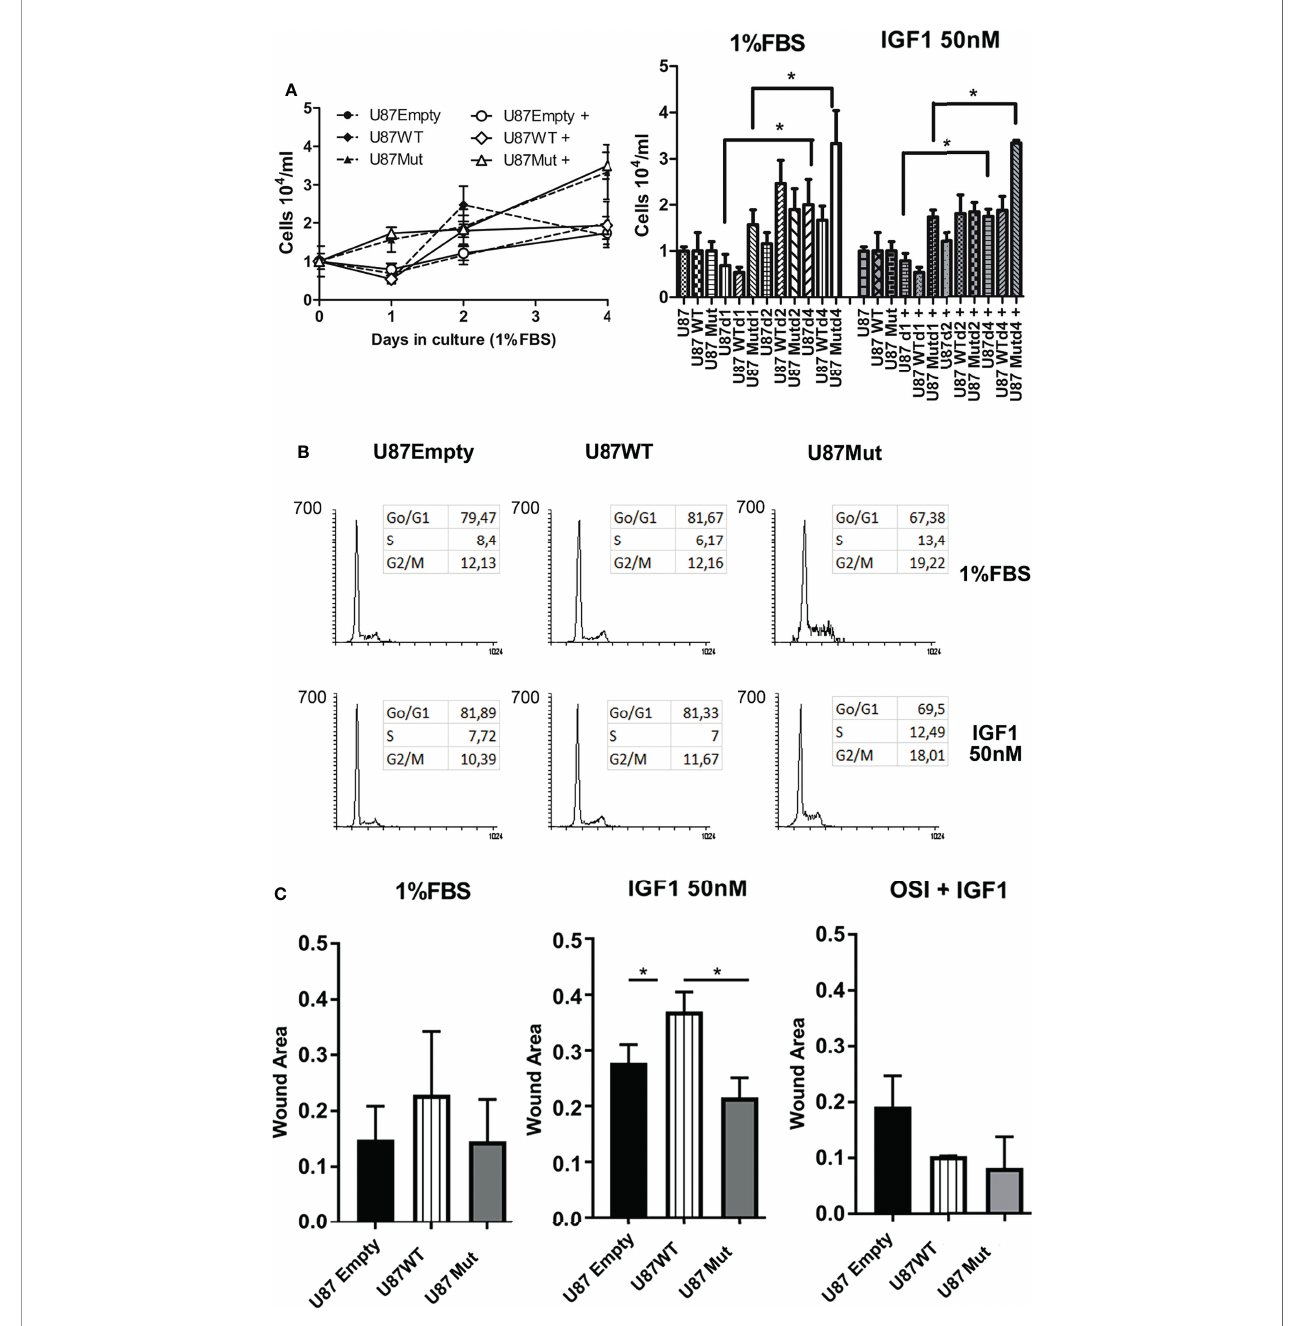
FIGURE 2 | Effects of IGF1R localization over the proliferation and migration of glioma cells. (A) Left: U87Empty (solid circles), U87WT (solid rhomboids), and U87Mut (solid triangles) cells were grown for 4 days with low serum concentration (1% FBS) or in the presence of 50 nM IGF1 [U87Empty + (open circles), U87WT+ (open rhomboids), and U87Mut+ (open triangles)]. The results of a representative experiment from a total of three performed in triplicates are shown; Right: total number of cells, according to cell line, days in culture, and treatment. Values are expressed as mean ± SD (* p < 0.05, ANOVA, Tukey ’ s post-test). (B) U87Empty, U87WT, and U87Mut cells were cultured 24 h in low-serum conditions (1% FBS) with or without 50 nM IGF1 stimulus, fi xed, stained with PI, and analyzed by fl ow cytometry. A representative experiment is shown. (C) Wounding assays were performed to U87Empty, U87WT, and U87Mut cell con fl uent cultures. The cells were grown for 36 h in low-serum conditions (1% FBS) or in the presence of 50 nM IGF1. To test the speci fi city of the response, the cells were pre-incubated (1 h) with 0.5 m M OSI906 (OSI+IGF1). The results obtained from three independent experiments are presented as the proportion of covered area related to time 0. Values are expressed as mean ± SD (* p < 0.05, ANOVA, Tukey ’ s